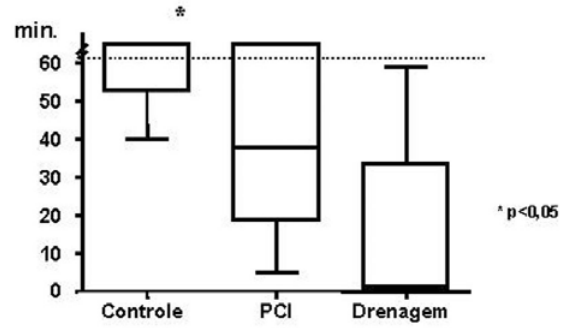
Fig. 5 -Tempo de recuperação do PESS, na fase de reperfusão medular, nos três grupos